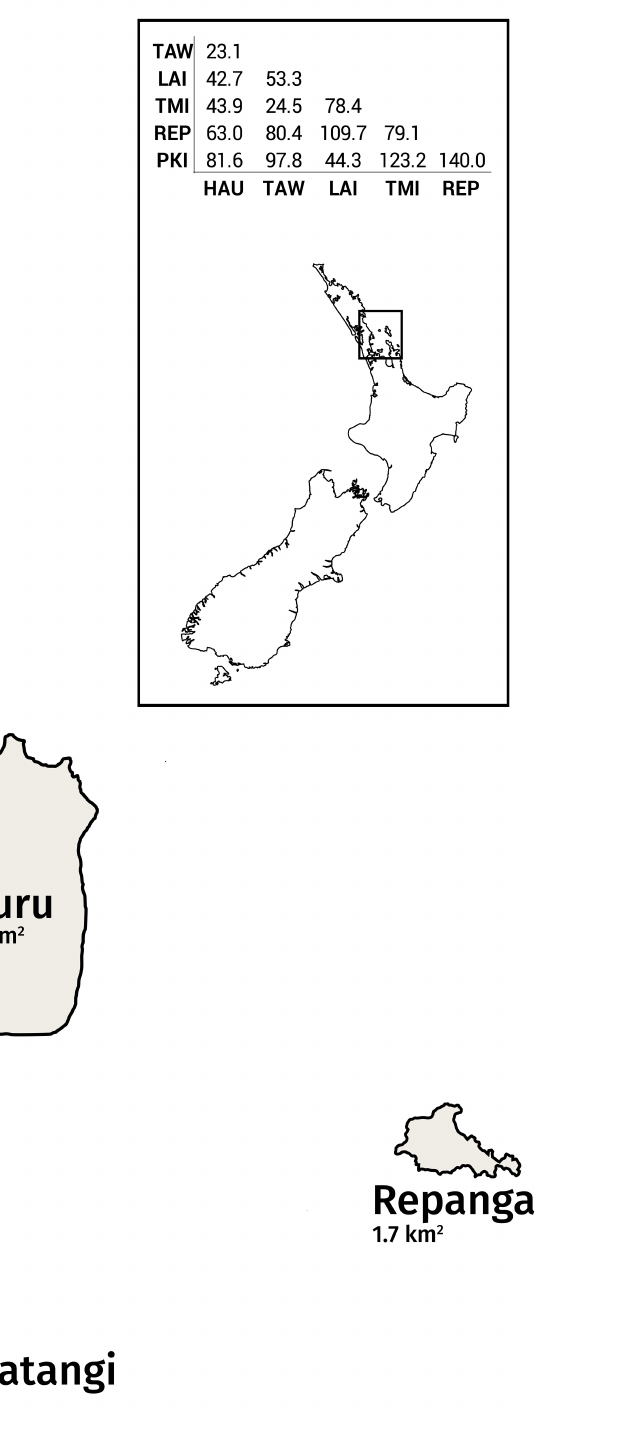
Frontiers in Ecology and Evolution |